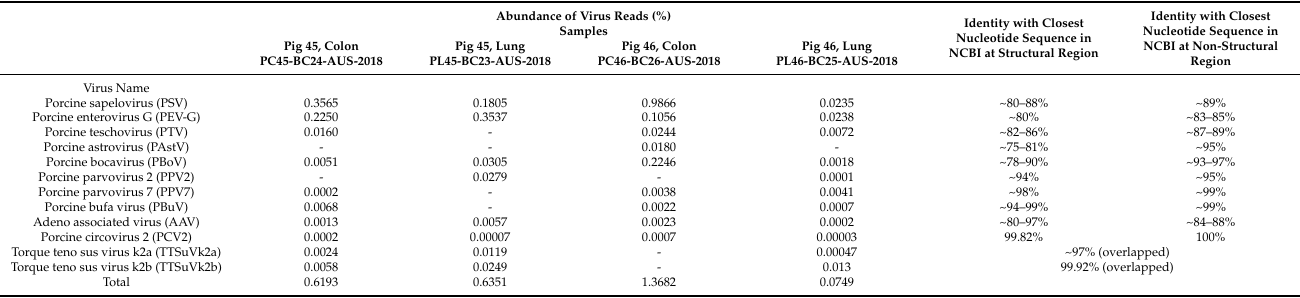
Table 1. The abundance of virus reads in the pig swab samples. Nucleotide identity percentage range with the closest reference sequence in the structural and non-structural region is shown. The structural and non-structural regions of TTSuV are overlapping and hence sequence identity with the closest reference has been shown in